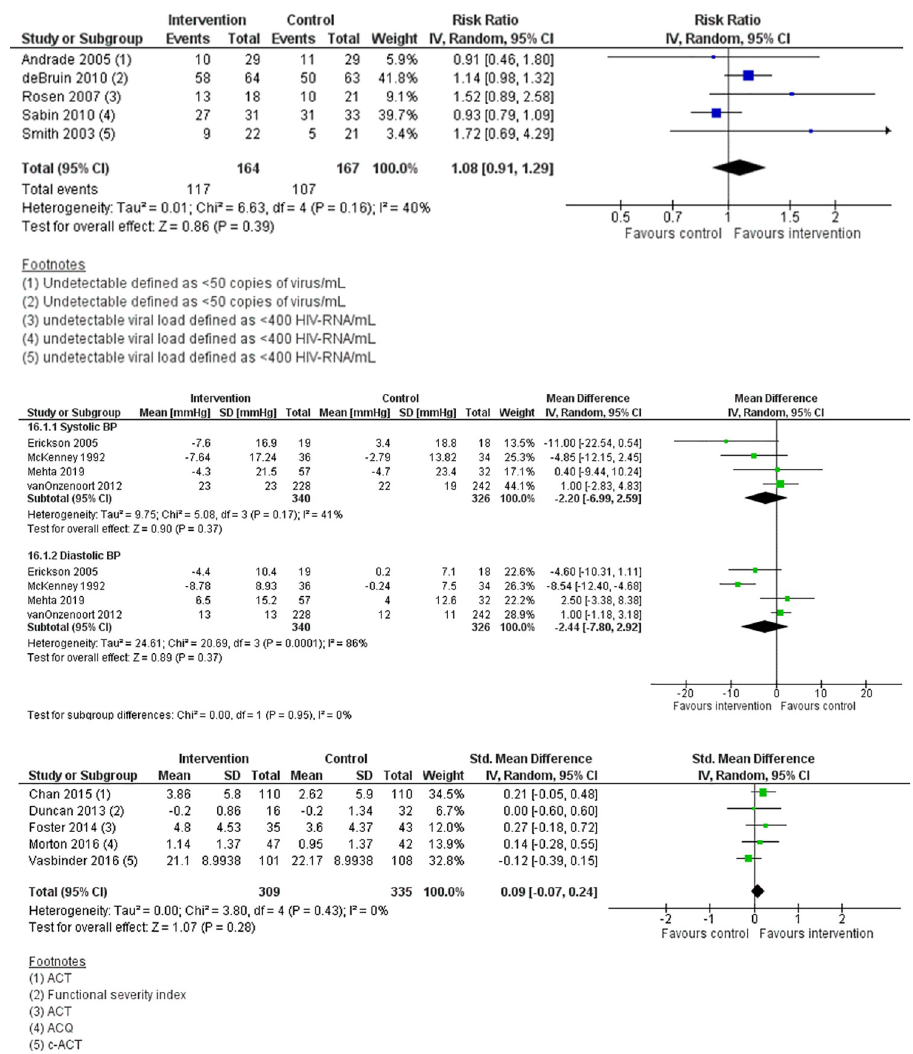
Fig 3. Forest plot of effect of the electronic adherence monitoring intervention compared to control on clinical outcomes by a) viral load for Human Immunodeficiency Virus; b) blood pressure for hypertension; c) asthma control for